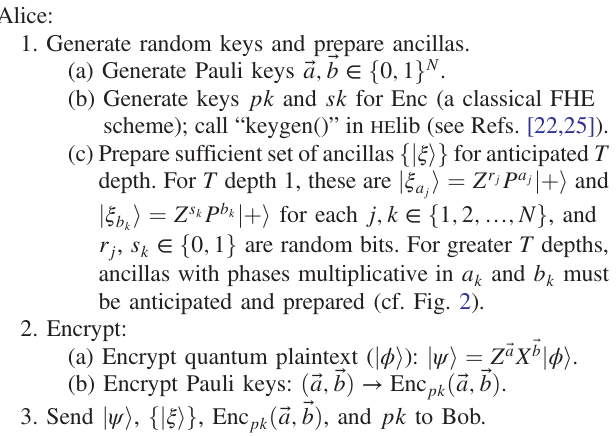
Algorithm 1. QFHE: Summary of